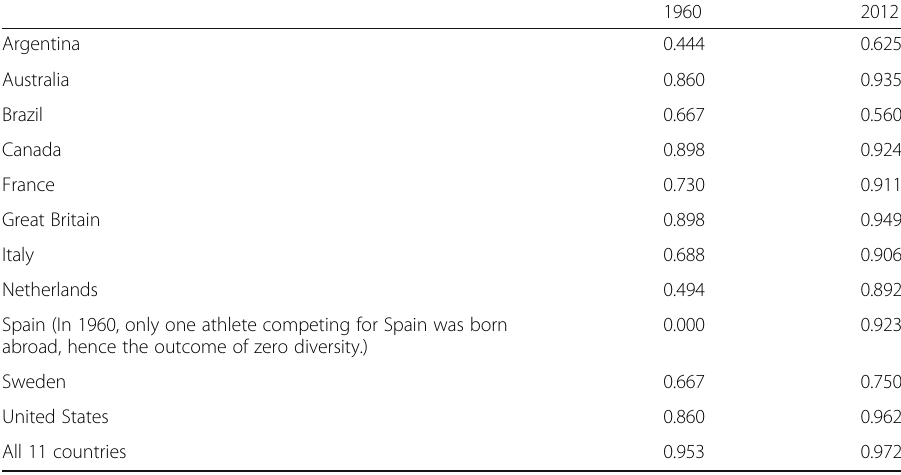
Table 2 Diversity (D) among foreign-born athletes